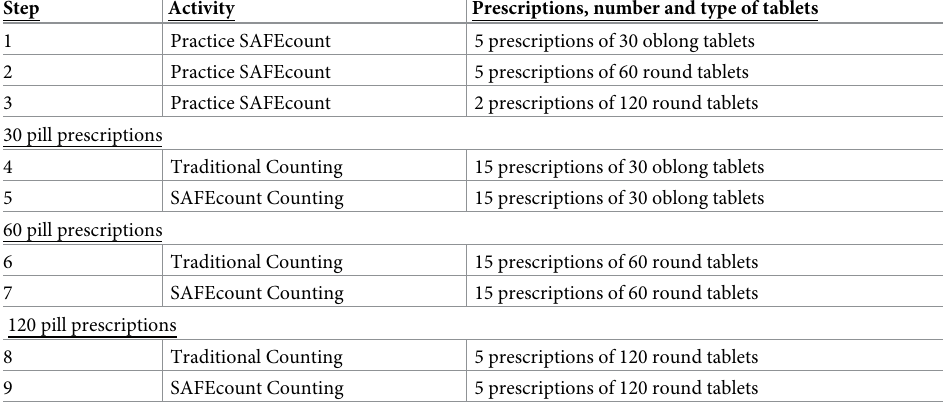
Table 1. Protocol for counting